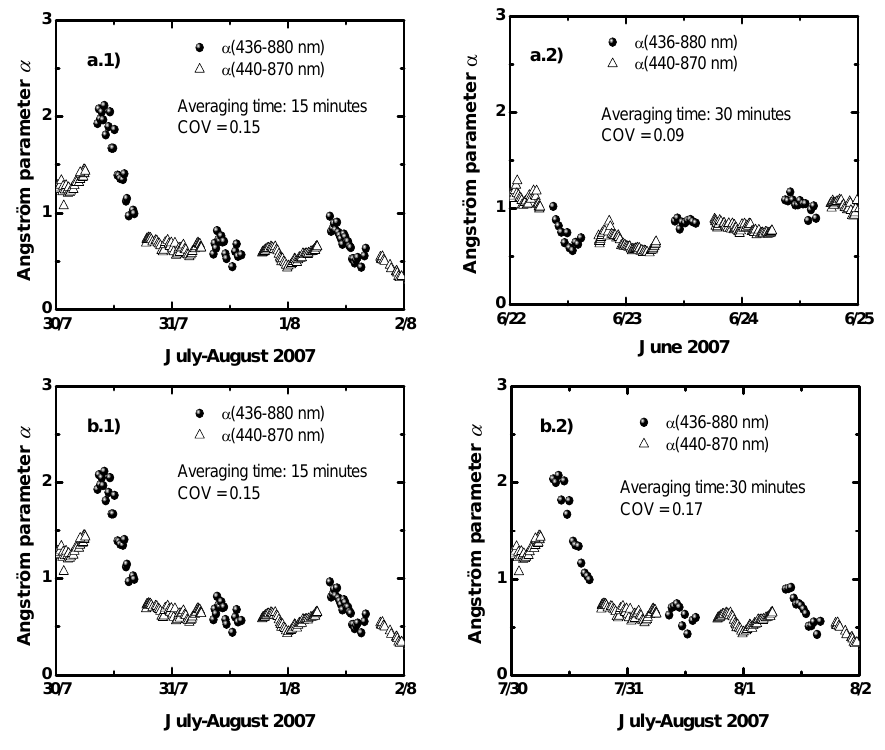
Fig. 4. Temporal evolution of day- and nighttime Angstr¨om parameter α . (a) From 22 to 25 June 2007. (b) From 30 July to 2 August 2007. The Angstr¨om parameter α (436–880nm) at nighttime was obtained from the average values of cloud-free aerosol optical depths at 15 or 30min while Angstr¨om parameter α (440–870nm) values obtained at day time are instantaneous cloud-free data after applying Smirnov et al. (2000) algorithm. The averaging times and the coefficient of variation, COV, are also included in the figure.